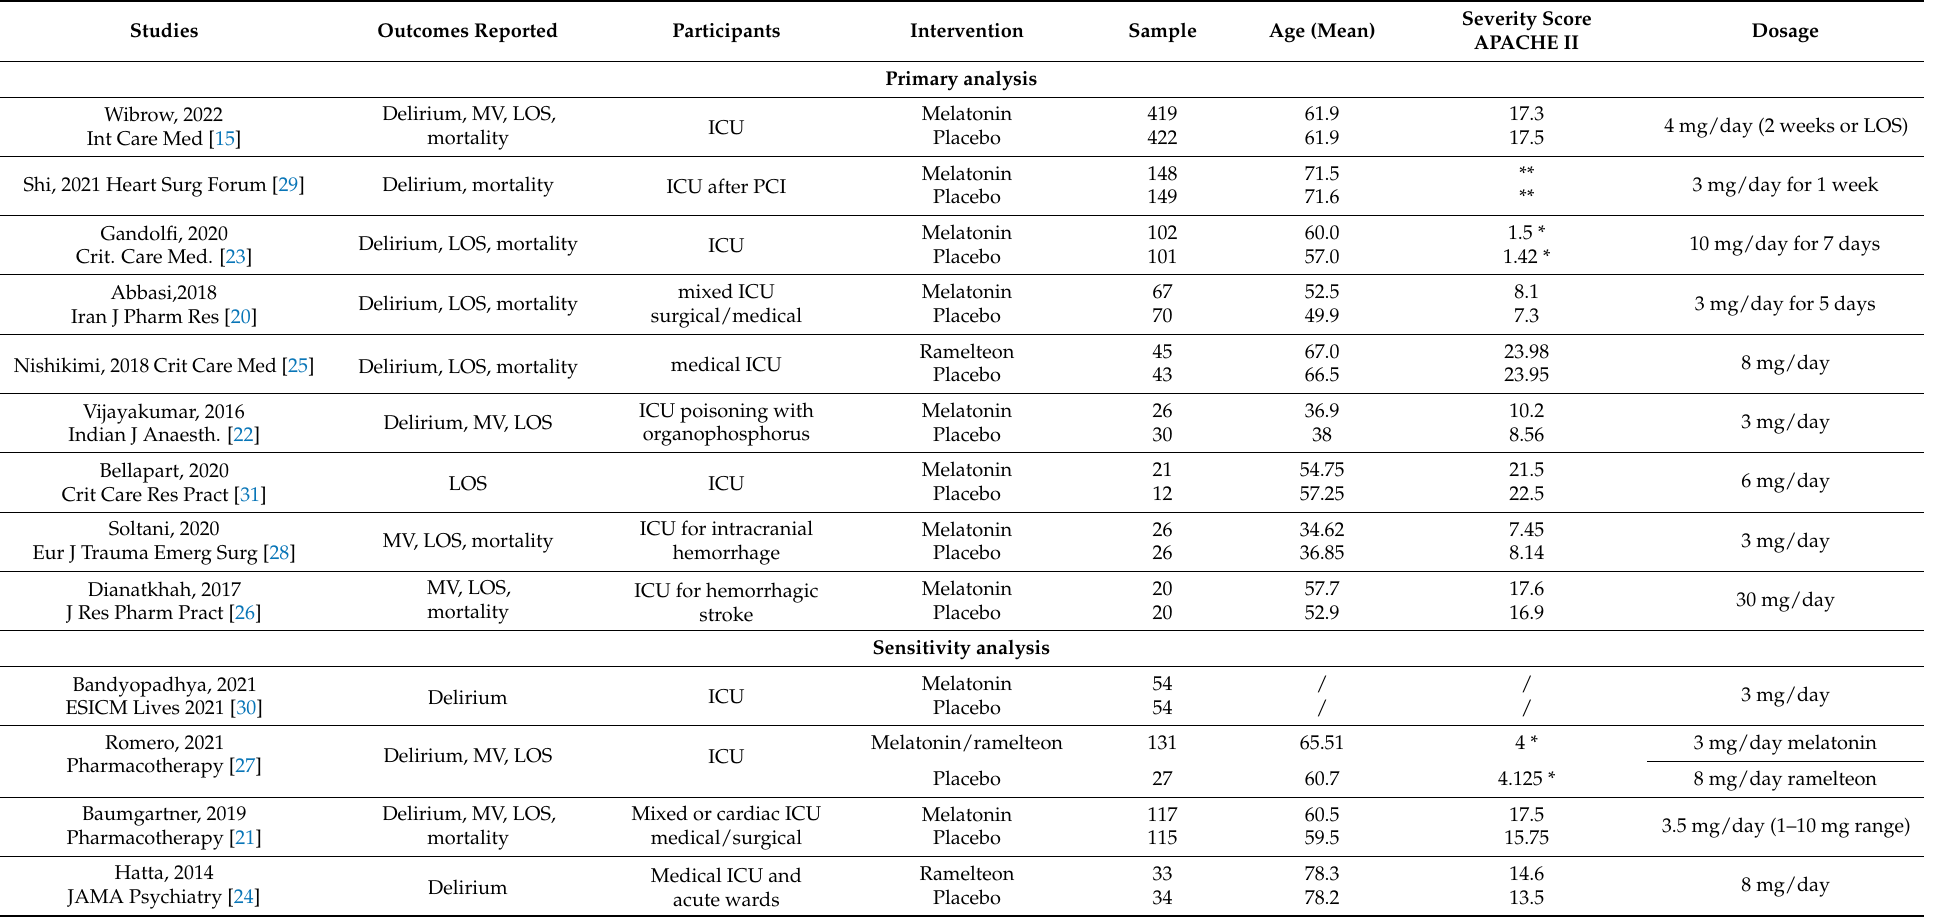
Table 1. Characteristics of the populations and the interventions in the included studies selected for meta-analysis. Studies are divided into primary and sensitivity